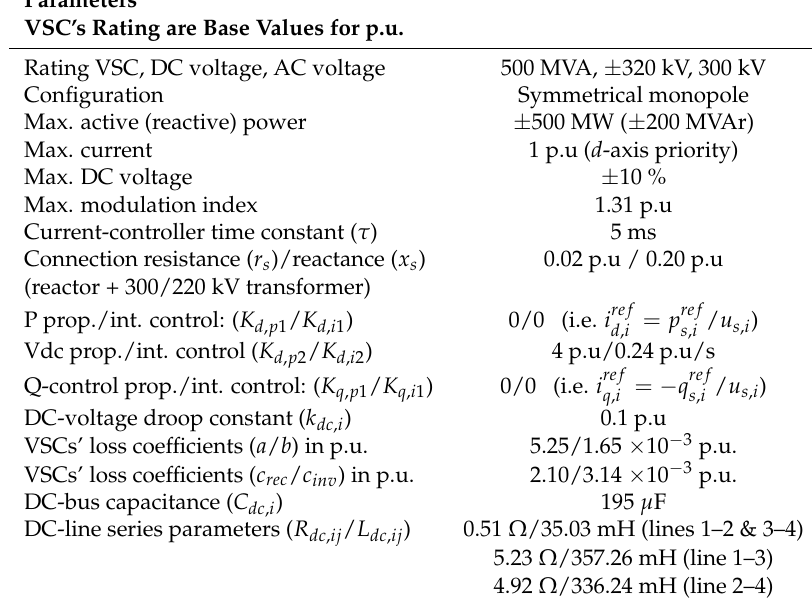
Table A1. Converter and HVDC grid parameters.